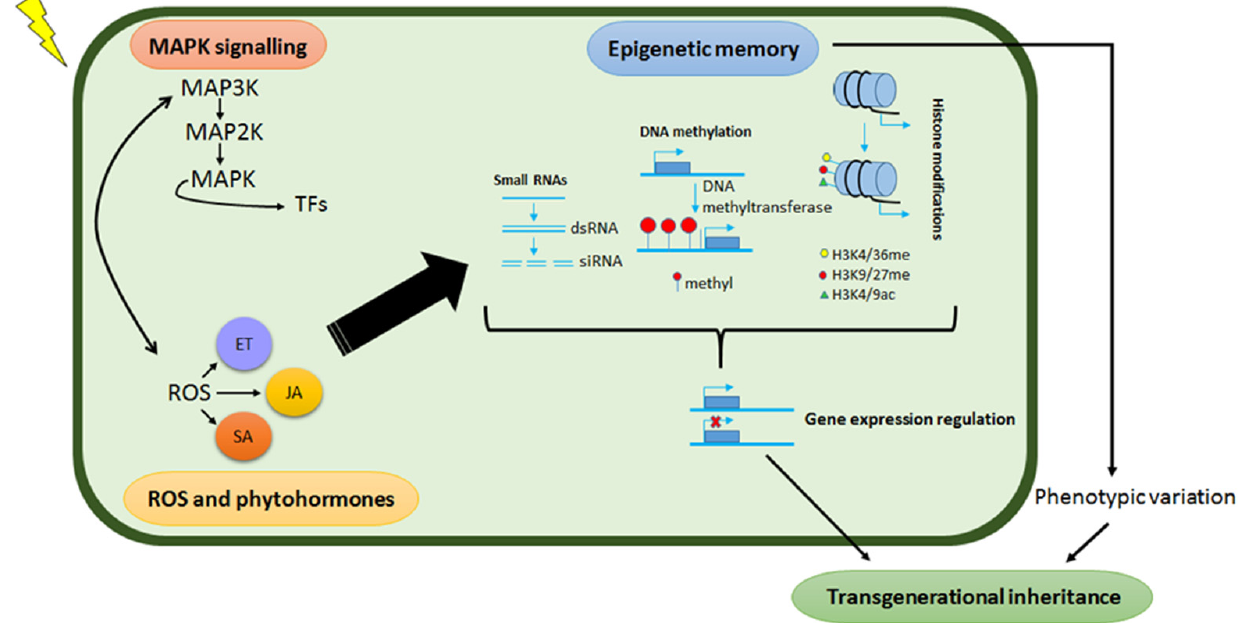
Figure 5. Simplified model of abiotic stress signalling pathways and their role in transgenerational epigenetic memory. Perception of environmental stress by plants induces the accumulation of ROS, which in turn promotes the production of phytohormones including SA, JA and ET. ROS further induce a MAPK signalling cascade that activates transcription factors, driving defence-related gene transcription. These stress-induced changes modulate the epigenetic landscape (small RNAs, DNA methylation and histone modifications) which subsequently affect gene expression patterns in response to abiotic stress. These epigenetic variations can be transient and revert to the initial epigenetic state. In some cases, induced epigenetic variations may be transmitted transgenerationally and may become adaptive if the offspring experiences environmental signals similar to the previous